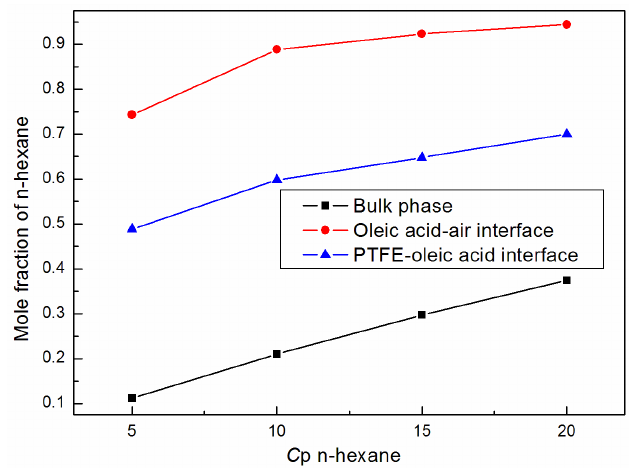
Figure 5. The values of n-hexane mole fraction in n-hexane and oleic acid mixture vs. its percentage concentration ( C p ).